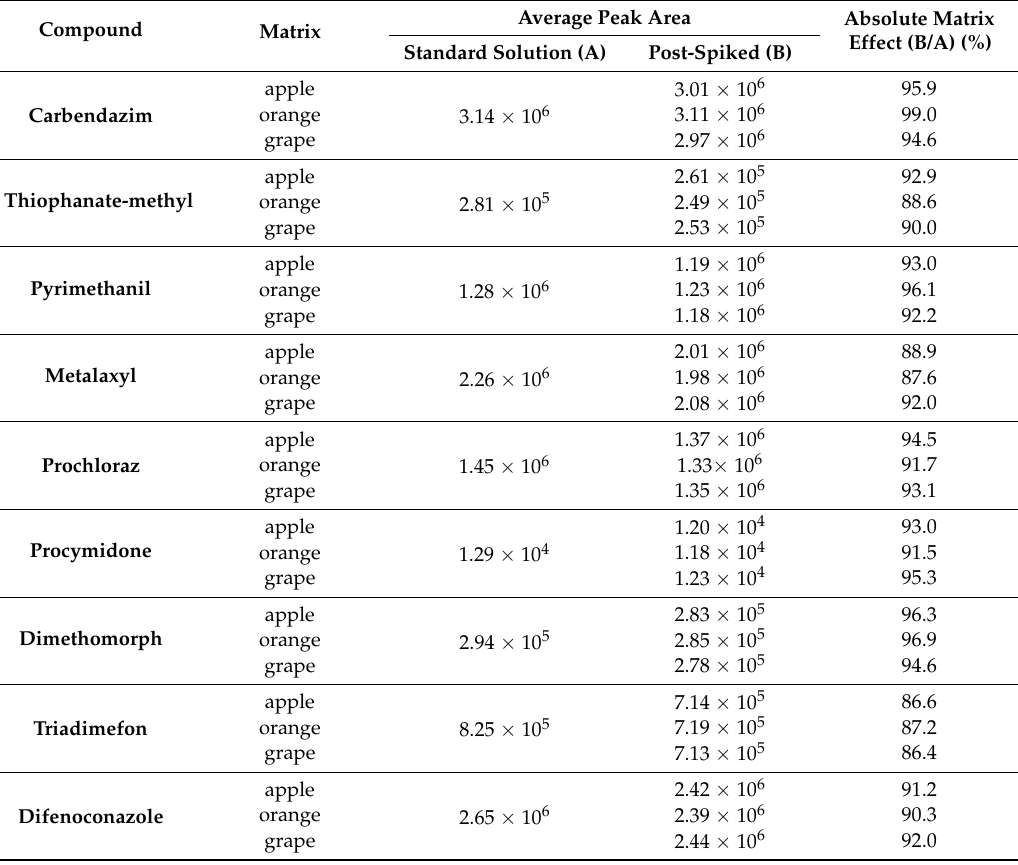
Table 2. Absolute matrix effect, expressed as the ratio in percentage obtained with a spiked matrix versus neat solvent standards (1.0 µ g/kg, n = 6).